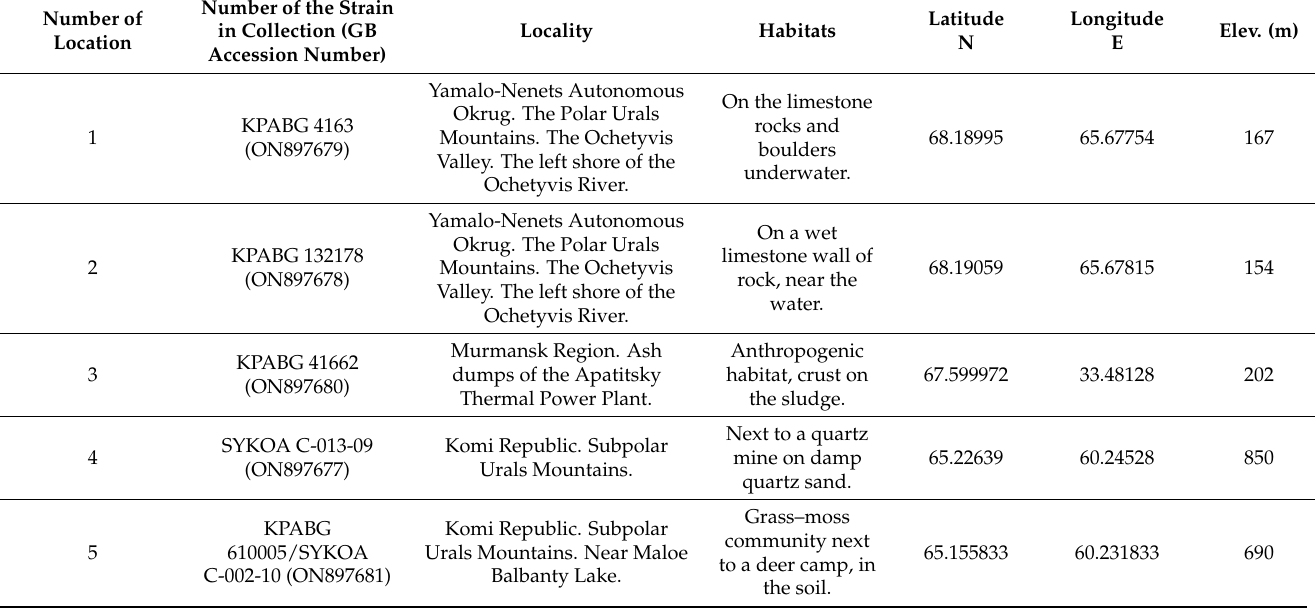
Table 1. The description of the sampling